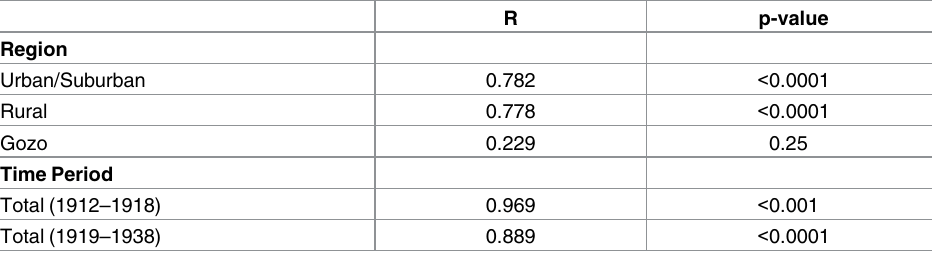
Table 1. Relationship between regional tuberculosis rates and Fisher